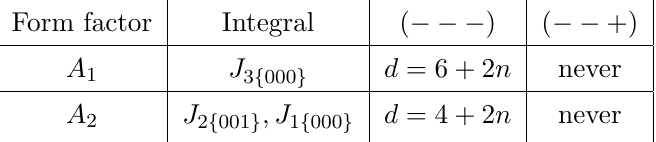
Table 1 . Singularities of triple- K integrals in the form factors for h J (cid:22) 1 J (cid:22) 2 J (cid:22) 3 i